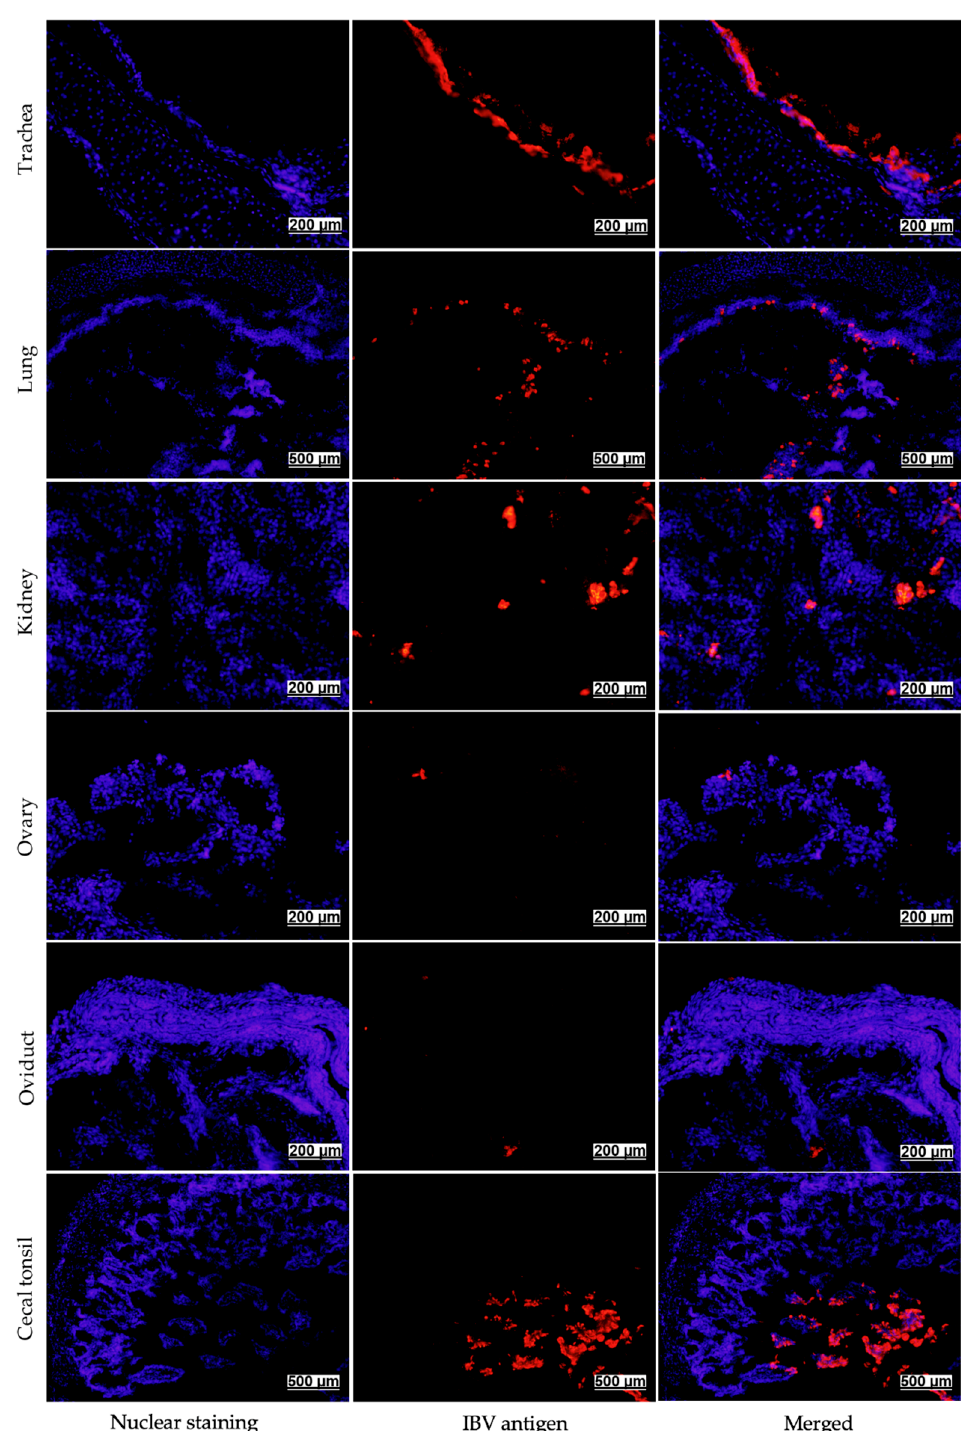
Figure 4. Immunofluorescence assay showing IBV antigens that were visualized with Dylight 594 ® (Red) in infected trachea, lung, kidney, ovary, oviduct, and cecal tonsil at 7 dpi following infection at 1-day of age. The nuclei were visualized using 4 ′ ,6-diamidino-2-phenylindole (DAPI) (blue).